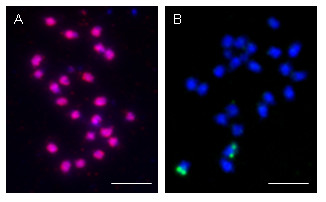
Chromosome preparations of M. acuminata cv. Calcutta-4 (2n = 22) stained with DAPI after FISH of BAC. (A) MA4_78I12 (detected with Texas red). (B) MA4_54N07 (detected FITC). Scale bar = 10 microns.